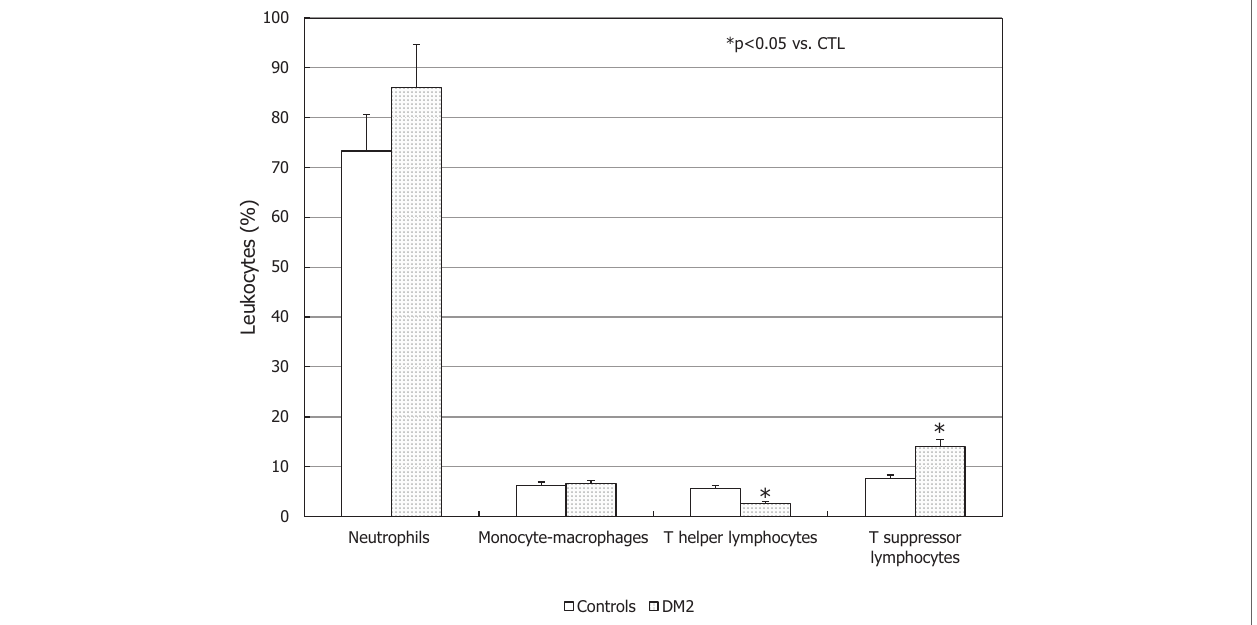
FigUre 4 | Leukocyte subpopulations in the seminal fluid of patients with type 2 diabetes mellitus (DM2) and controls (CTL). * p < 0.05 vs. CTL. Data are expressed as mean ±